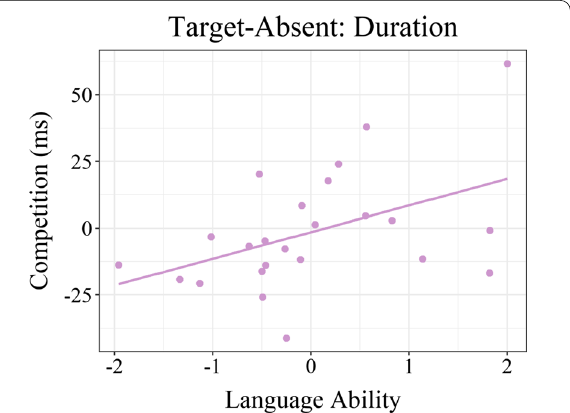
Fig. 3 Relationship between language ability ( z- score) and the relative duration of competitor fixations (competitor—control) in milliseconds. Higher scores were associated with significantly greater phonological